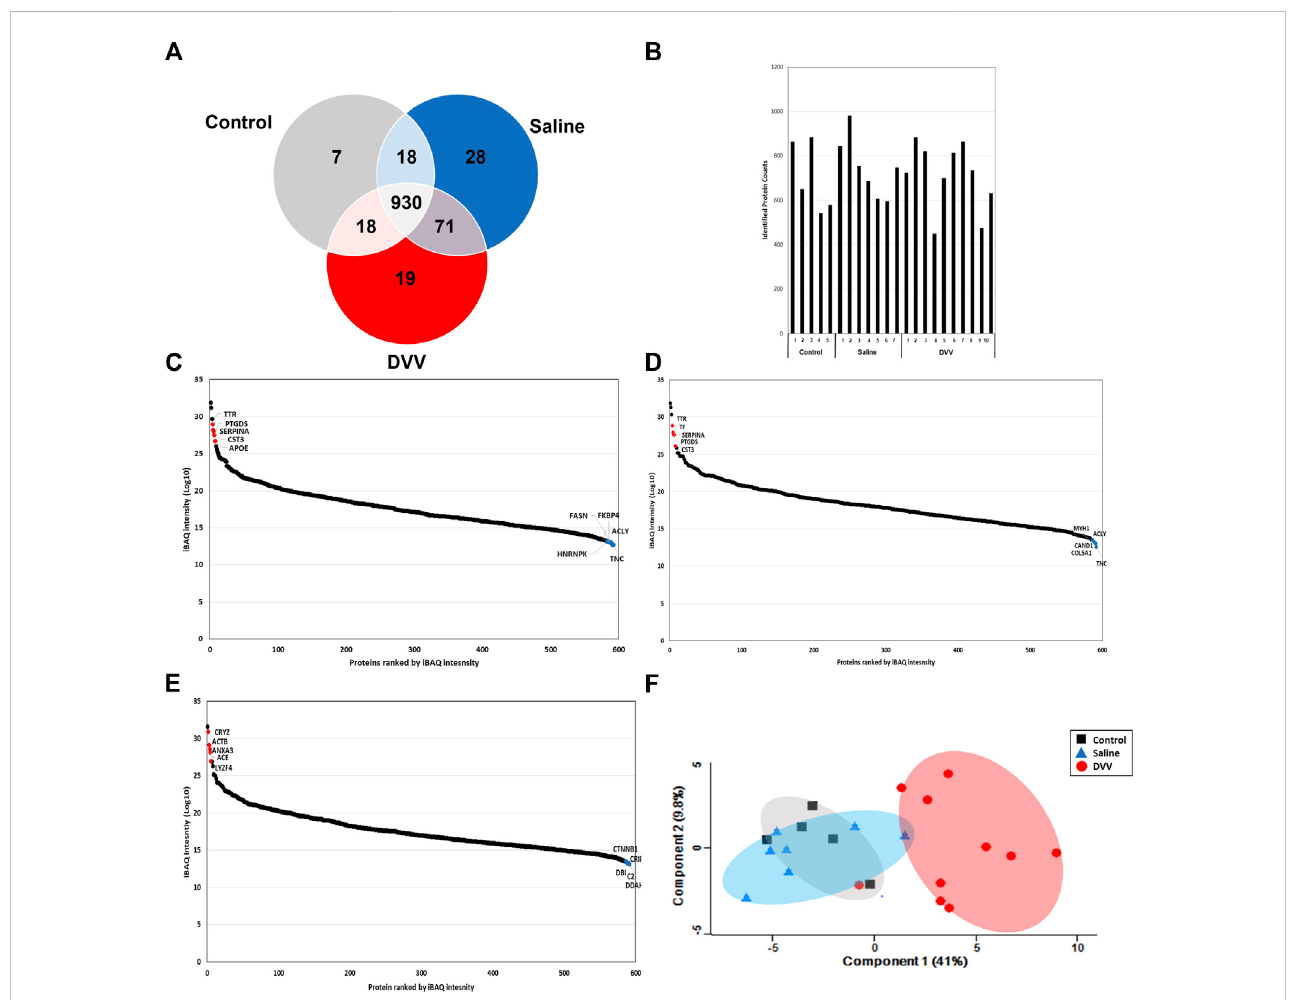
FIGURE 2 (A) Identi fi ed number of proteins and common DEPs from control, saline, and DVV group from LC-MS/MS analysis. (B) Number of identi fi ed proteins of eachanalyzedsample. (C) Dynamicrangeofproteinabundancewithtop5upanddownregulatedproteinsfromcontrol, (D) saline,and (E) DVVgroup. (F) The PCA plot of protein expressions from each group after width adjustment